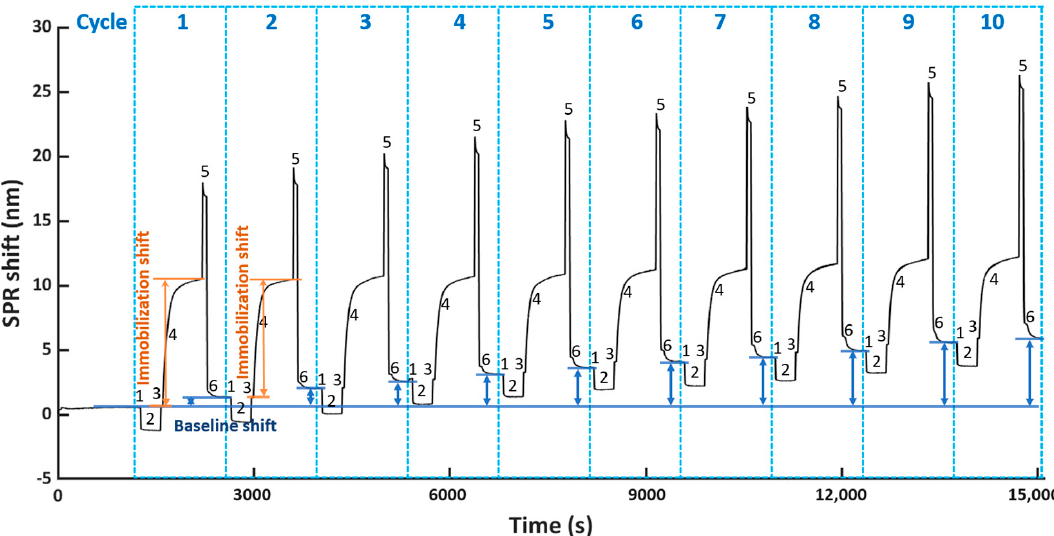
Figure 3. The FO − SPR sensorgram representing ten regeneration cycles, including (1, 3 and 6) TBS stabilization, (2) formation of the Co(II) − NTA chelate, (4) immobilization of scFv − 33H1F7 at 20 µ g/mL and (5) removal of scFv − 33H1F7 to regenerate the NTA surface using condition G. The baseline shift (blue arrows) for each cycle and the immobilization shift for cycle 1 and 2 (orange arrow) are depicted.